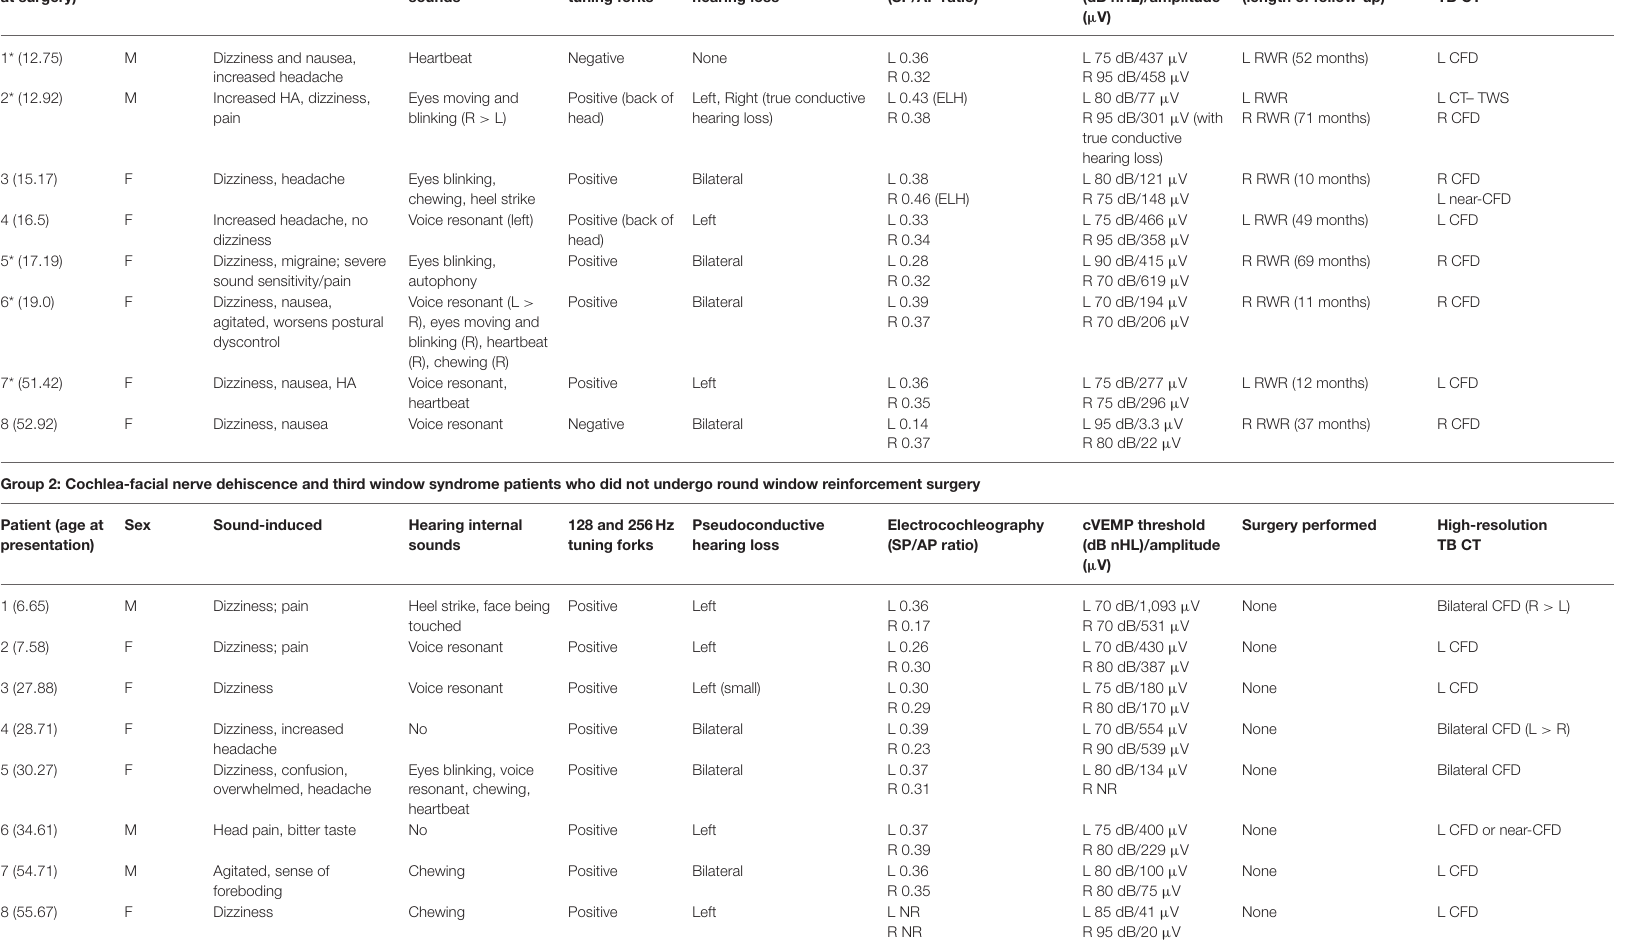
TABLE 1 | Patient third window syndrome symptoms, physical findings, and results of diagnostic studies in 16 patients with cochlea-facial nerve dehiscence. Group 1: Cochlea-facial nerve dehiscence and third window syndrome patients who underwent round window reinforcement surgery Patient (age at surgery)